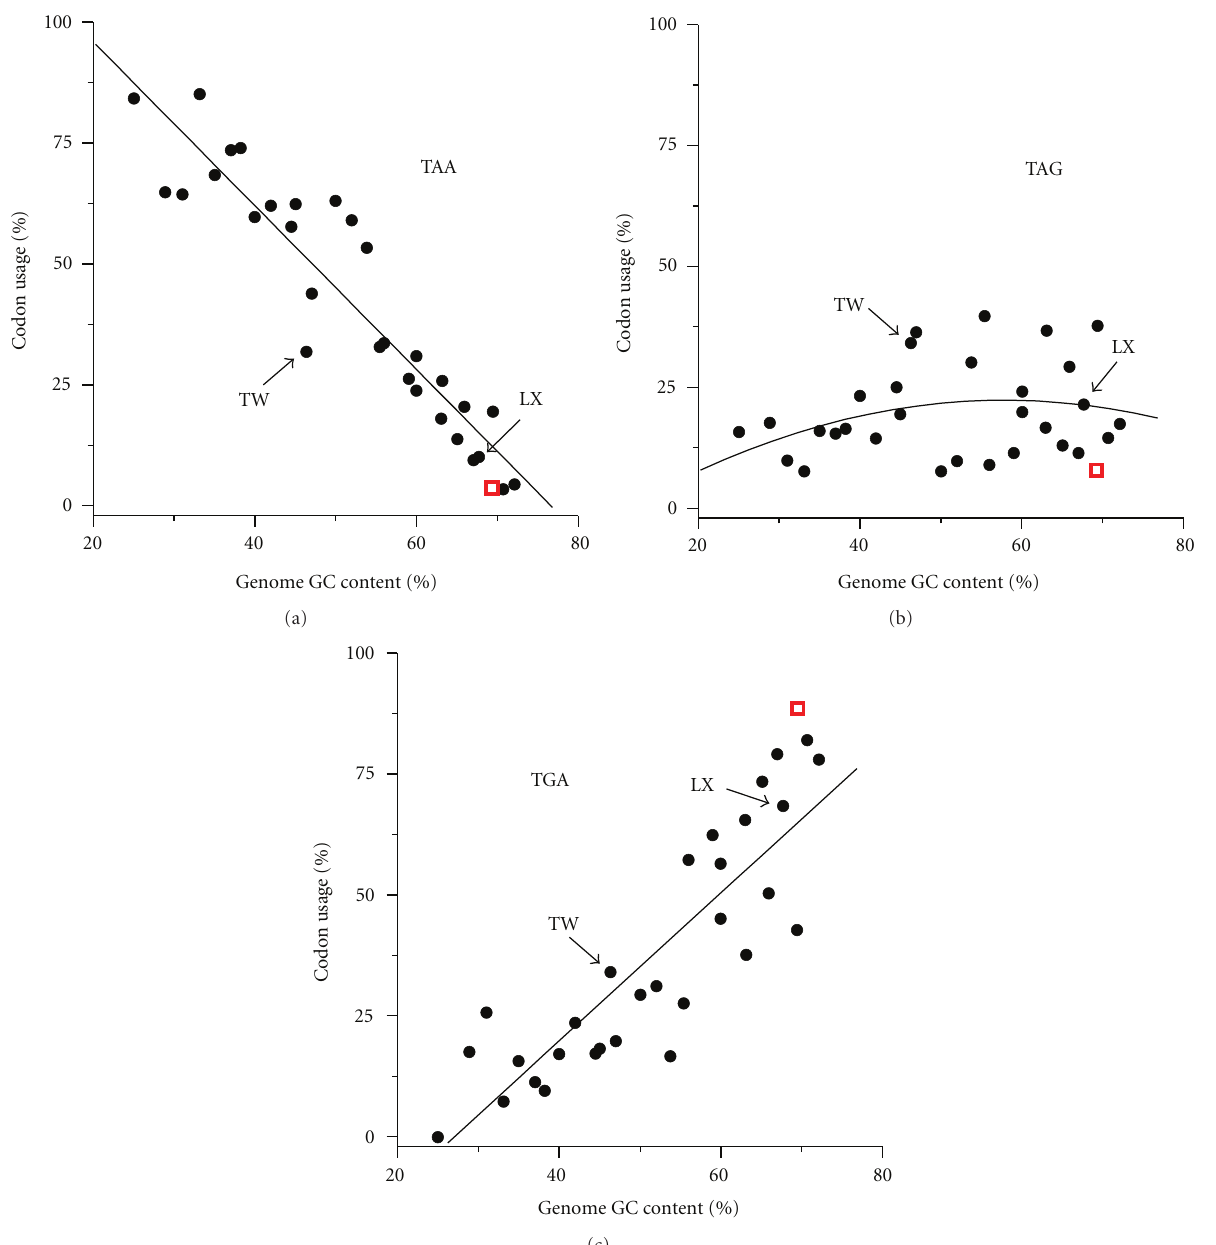
Figure 2: Correlation of stop codon usage and the GC content of bacterial genomes. The abundance of the stop codons were plotted against the genomic GC contents. Same kind of calculation based on the 27 predicted genes on the M. arborescens contig was shown as red open boxes. T. whipplei (TW) and L. xyli (LX), two species closely related to M. arborescens , were highlighted by arrows. The bacterial species were listed in Supplementary Table S1 available online at doi: